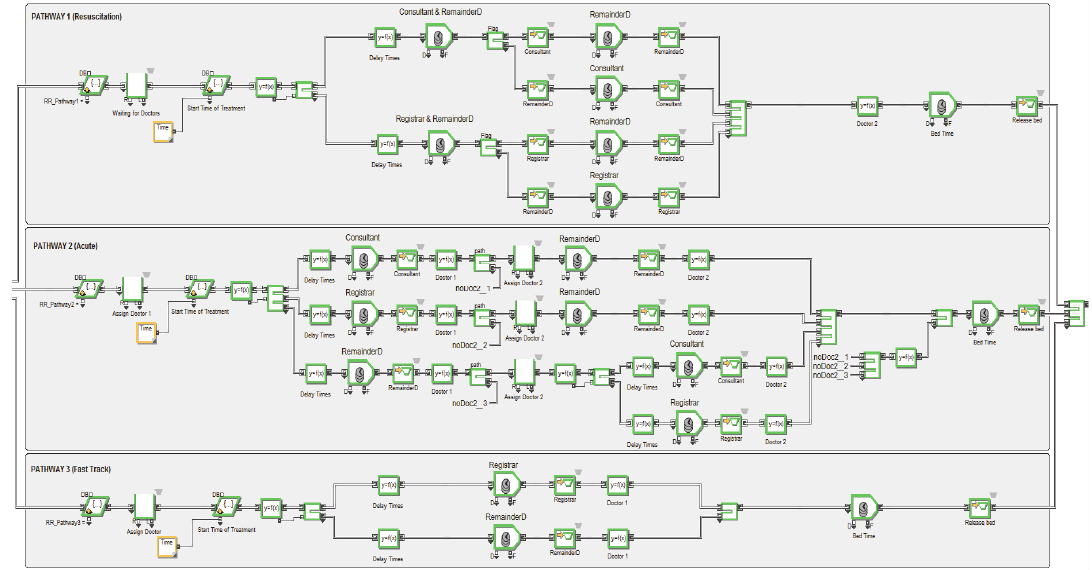
Fig. 8. ExtendSim model of the ED